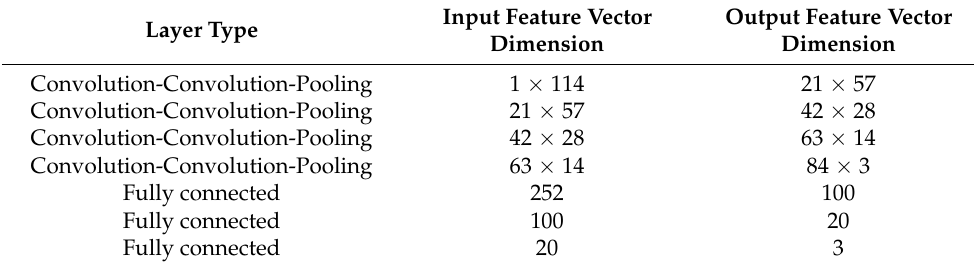
Table 1. Structure of the one-dimensional convolutional neural